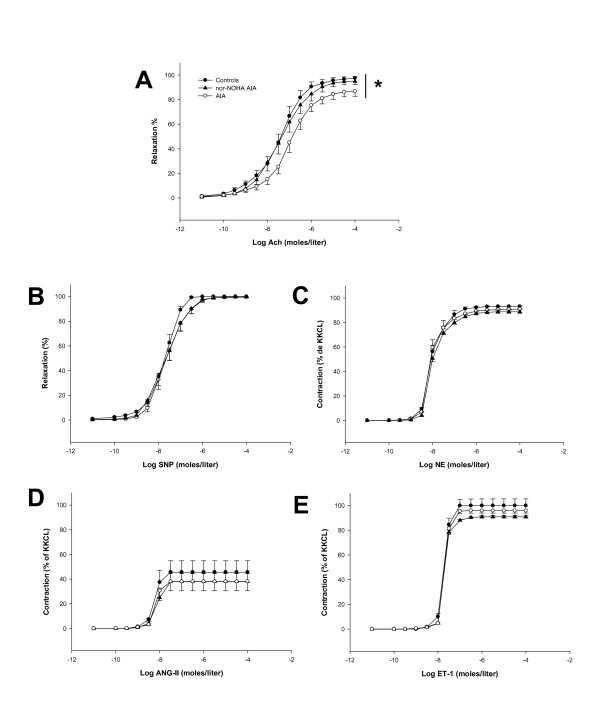
Vascular reactivity to vasodilators and vasoconstrictive agents. Experiments were performed on thoracic aortic rings from control rats, AIA rats and nor-NOHA AIA rats 21 days after the onset of arthritis. A, Concentration - response curve for Ach in endothelium-intact rings preconstricted with NE 3 × 10-7 moles/liter. B, Concentration - response curve for SNP in endothelium-denuded rings preconstricted with NE 3 × 10-7 moles/liter. C, Concentration - response curve for NE in endothelium-denuded rings, D, Concentration - response curve for ANG-II in endothelium-denuded rings, E, Concentration - response curve for ET-1 in endothelium-denuded rings. Values are the mean ± SEM from 8 to 12 rings. * = P < 0.05. KKCl = Krebs potassium chloride solution.